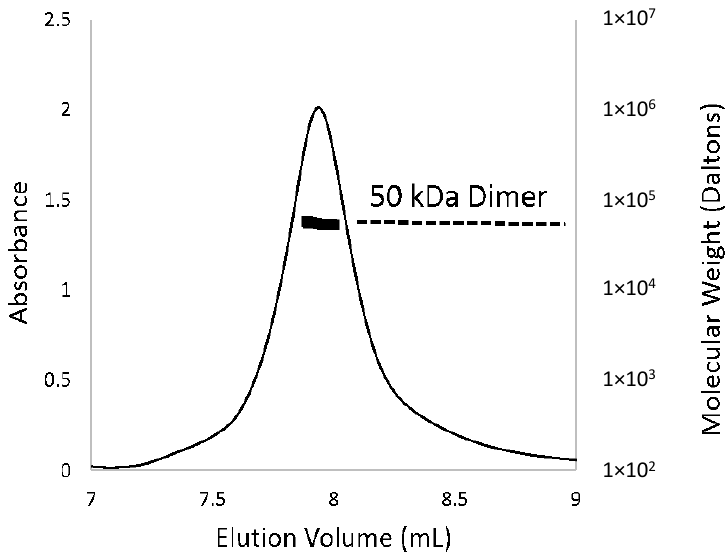
Figure 3. Oligomeric state of PcpR in solution. The elution profile for PcpR was monitored with multi-angle laser light scattering and was shown as absorbance (left- Y axis) and molecular weight (right- Y axis) versus elution volume (mL). The solid line represents changes in absorption at 280 nm. The thick black cluster in the middle of the peak indicated the calculated molecular mass (~50 kD) from the light scattering illustrating the dimeric nature of